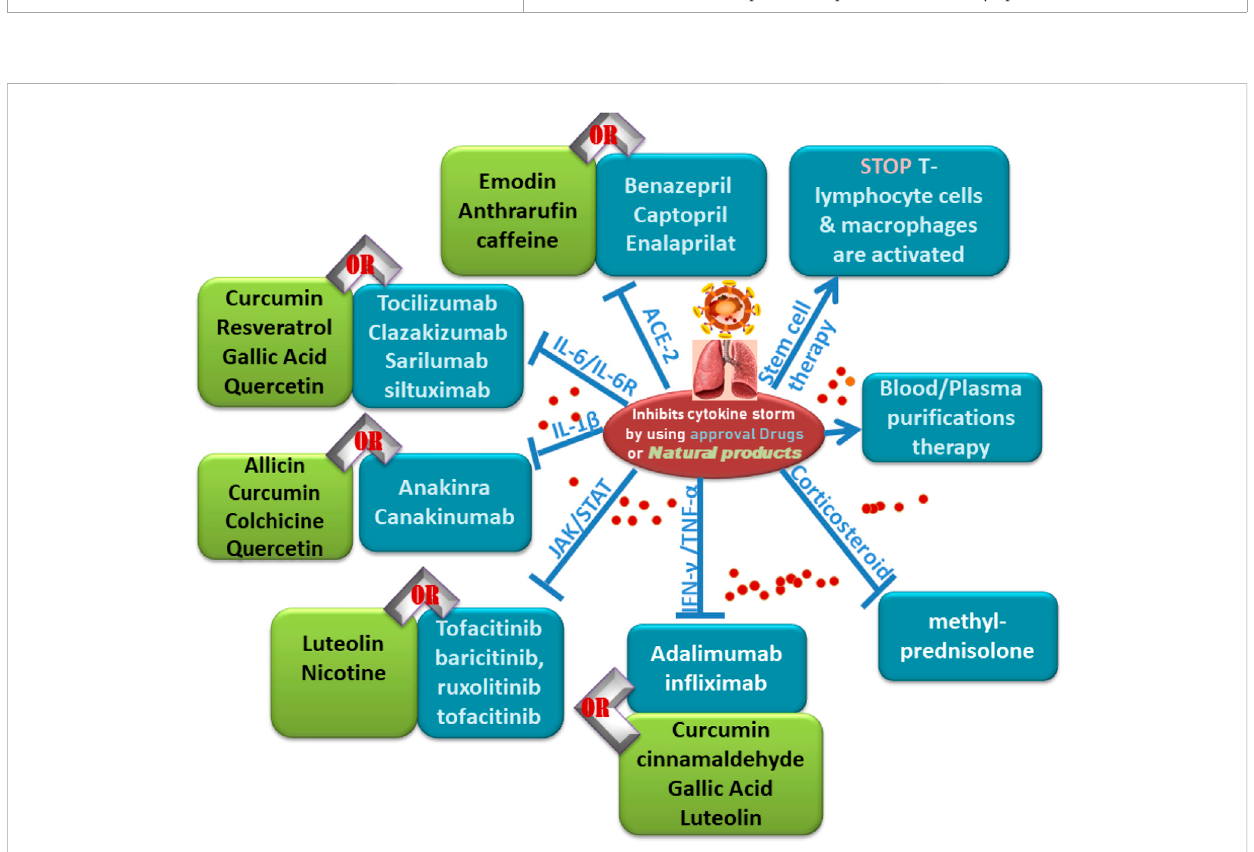
FIGURE 8 Follow charts: Different Inhibitors of cytokine storms by using approved drugs or natural products.